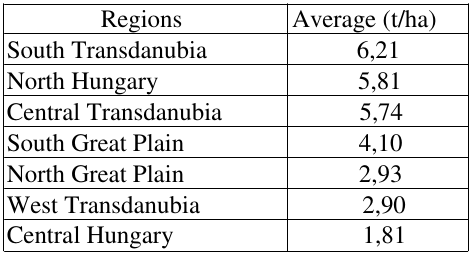
Table 3: The level of sour cherry production per region